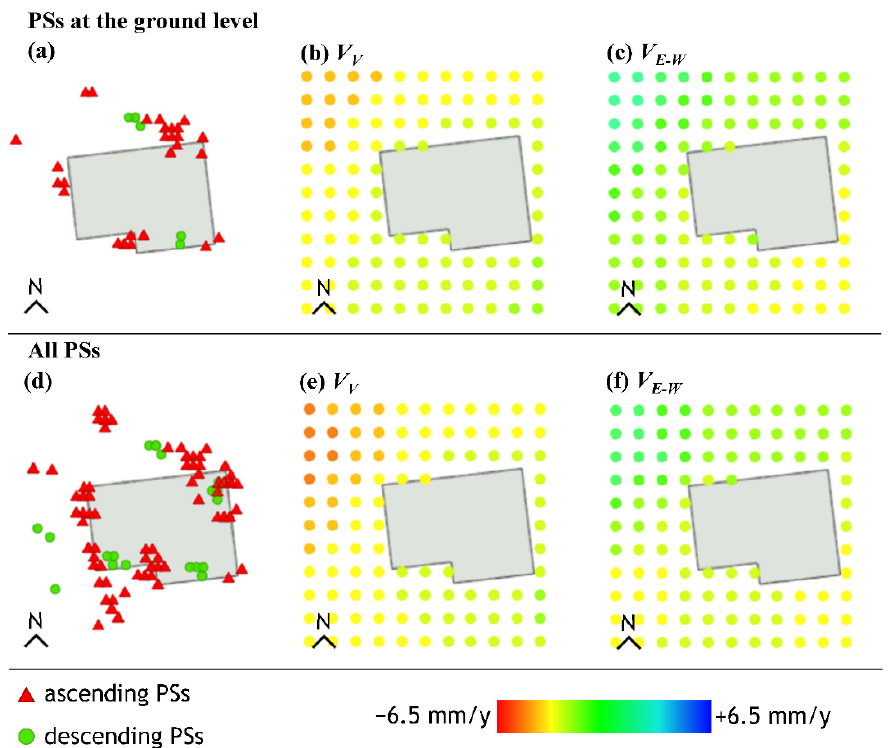
Figure 12. Collector sewer point of disposal n. 7 . Considering PSs at the ground level: ( a ) ascending and descending PSs; mean velocity maps at the ground level along ( b ) vertical and ( c ) E–W direction. Considering all PSs: ( d ) ascending and descending PSs; global mean velocity maps along ( e ) vertical and ( f ) E–W direction.